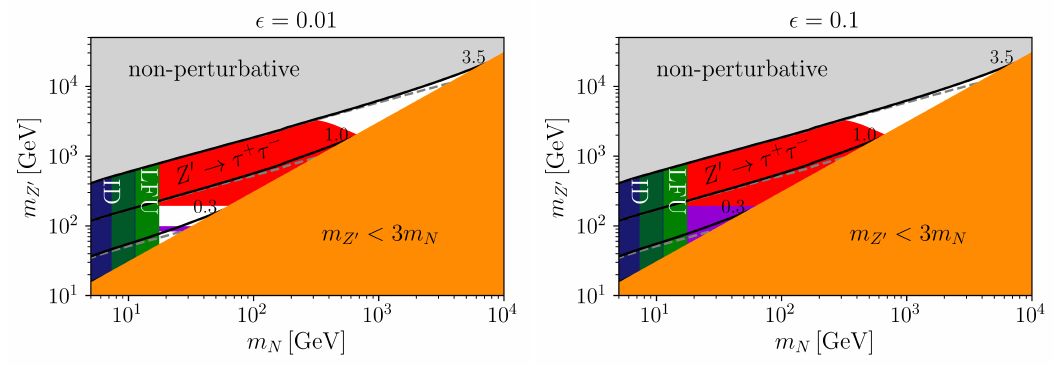
Figure 5: Parameter range of the gauged ( B − L ) model for Z - Z (cid:48) mixing parameters 3 ε = 0.01 (left) and ε = 0.1 (right). Contours of g producing the correct relic X abundance are shown in black, while the dashed lines represent the EFT limit upon identifying Λ = m and c = g 2 with c defined in Eq.(33). For a given value of Z (cid:48) X ε the purple areas are ruled out at 95% CL. The area with m < 3 m is drawn Z (cid:48) N to signify where the EFT language is valid, namely in the upper left corner.